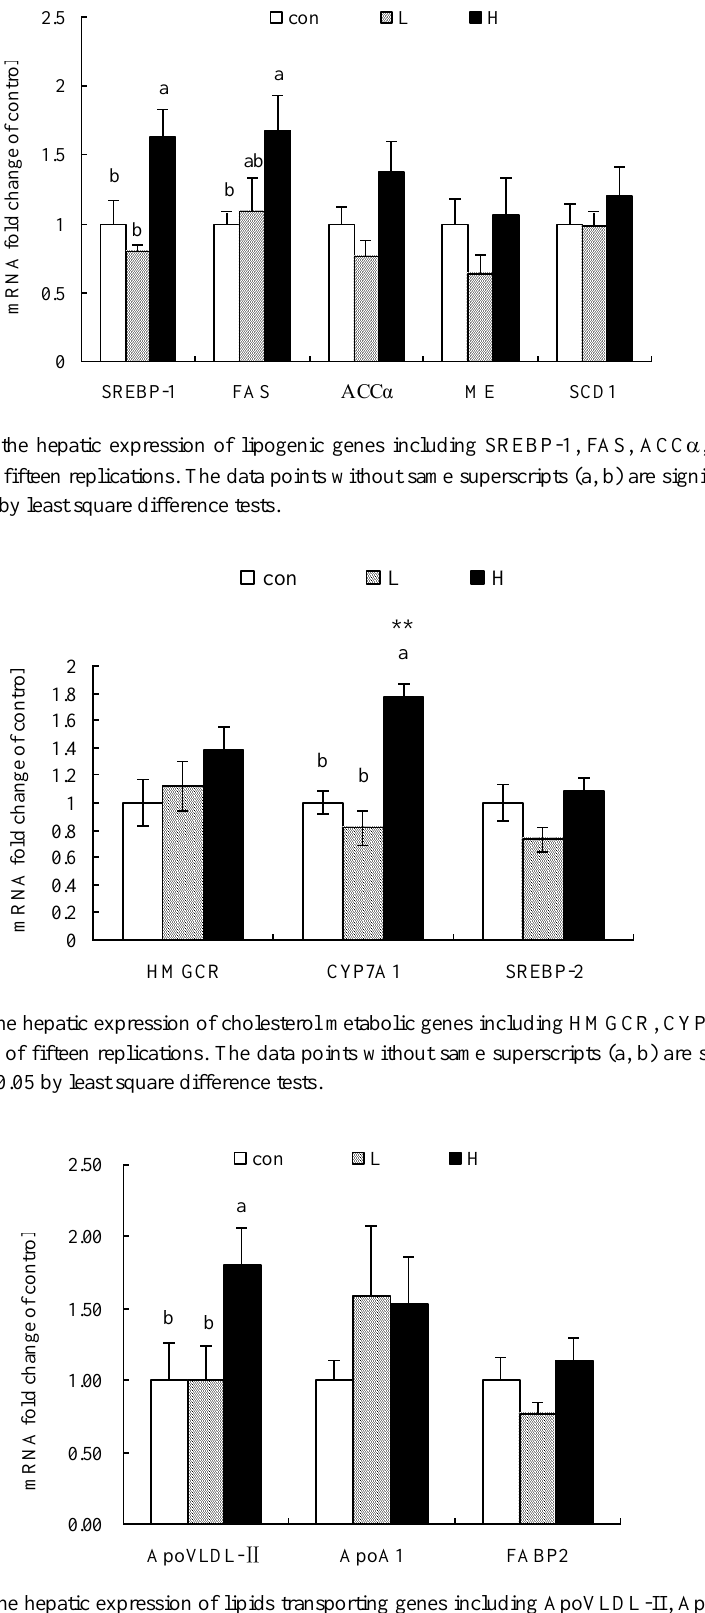
Figure 3. Effects of Kp-10 on the hepatic expression of lipids transporting genes including ApoVLDL-II, ApoA1 and FABP2 mRNA in quails. Values are means  SE of fifteen replications. The data points without same superscripts (a, b) are significantly different (one-way ANOVA) at the level of p<0.05 by least square difference tests.